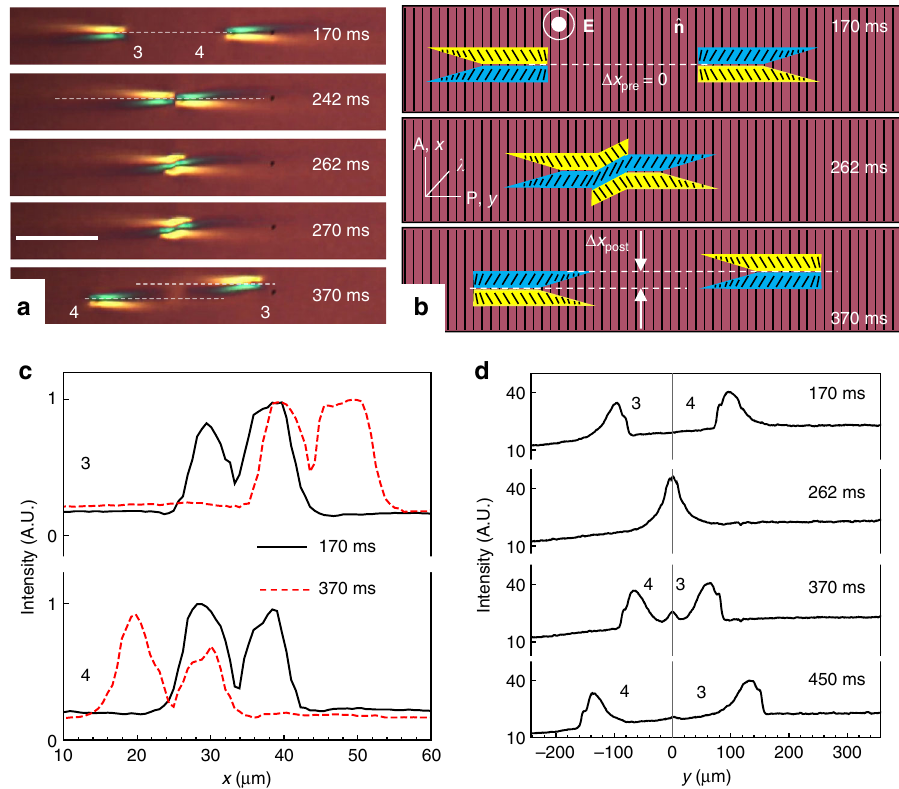
Fig. 8 Collision and recurrence of solitons. a . Polarizing microscopy textures of collision of solitons “ 3 ” and “ 4 ” ; Δ x pre < w /2; U = 55.2 V, f = 800Hz, T = 50°C, d = 8.0 μ m; scale bar 100 µ m; the same solitons are also shown in Fig. 7a. b Corresponding in-plane director schemes. c Transmitted light intensity for solitons as a function of x -coordinate before and after collision (measured along the line i = 15 in Fig. 1b). The left and right sides are of different intensity because of the presence of the red plate that imparts the blue and yellow interference colors on the two sides of the soliton. d Pro fi les of the solitons as a function of y -coordinate before and after collision, obtained by integrating light intensity transmitted through the soliton width (along the x